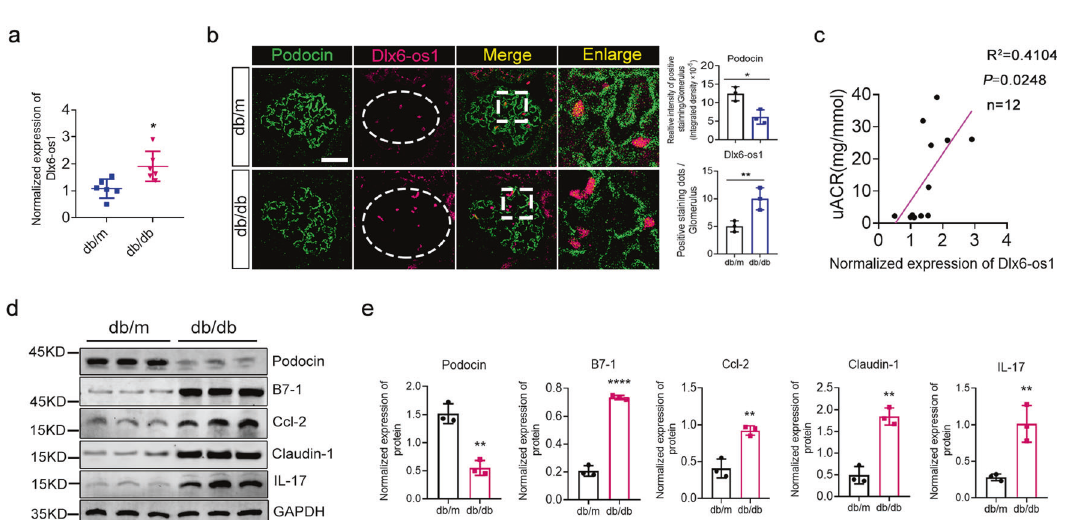
Fig. 2 A correlation between increased lncRNA Dlx6-os1 expression and increased podocyte injury in the db/db mice model with diabetic nephropathy. a qRT-PCR assays showing a signi fi cant increase in lncRNA Dlx6-os1 expression in isolated podocytes from mouse kidney. * P < 0.05 vs. db/m (unpaired t -test). n = 6 mice/group. b FISH-based detection of the expression level and location of lncRNA Dlx6-os1 in paraf fi n-embedded db/db mouse kidney. The expression of lncRNA Dlx6-os1 in podocyte of db/db mice is upregulated (magenta dots increased), and the expression of podocyte marker protein podocin (green) was reduced. The intensity of the staining is quanti fi ed and compared in the different samples ( n = 3). * P < 0.05, ** P < 0.01, (unpaired t -test). Scale bar = 20 µm. Three visual fi elds were analyzed